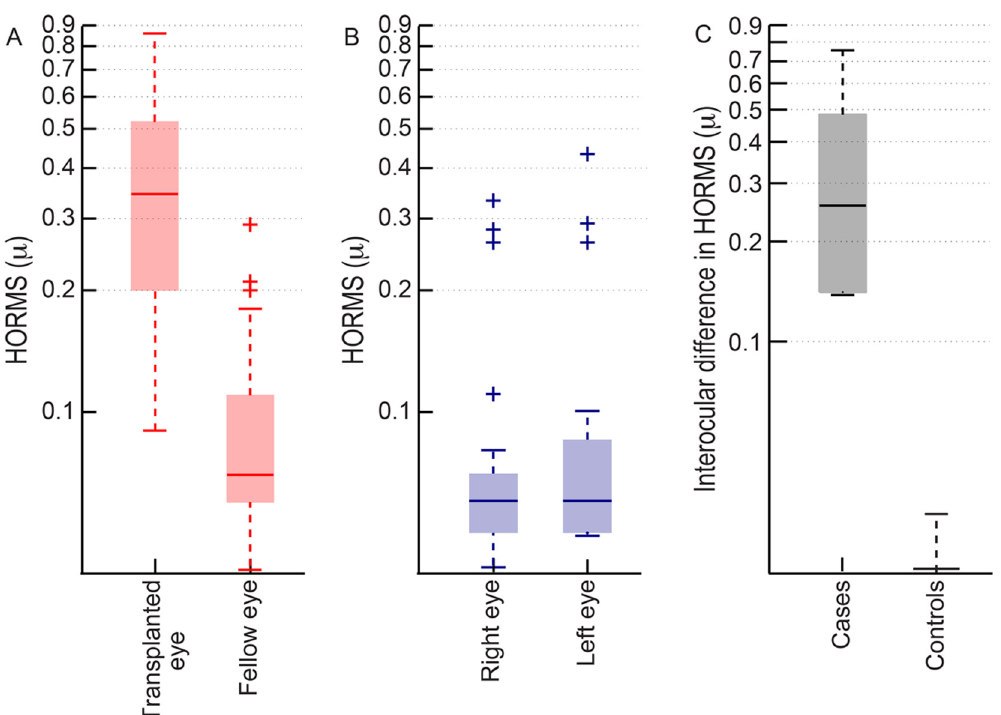
Fig 1. Box and Whisker plot of the RMS deviation of higher-order wavefront aberrations (HORMS) measured for 3mm pupil diameter for cases (panel A) and controls (panel B) that participated in this study. Panel C: The interocular difference in HORMS for cases and controls that participated in this study. The solid horizontal line within the box indicates median value, lower and upper edges of the box indicate the 25 th and 75 th interquartile range (IQR), lower and upper whiskers show the 1 st and 99 th quartiles and plus symbols indicate outliers.